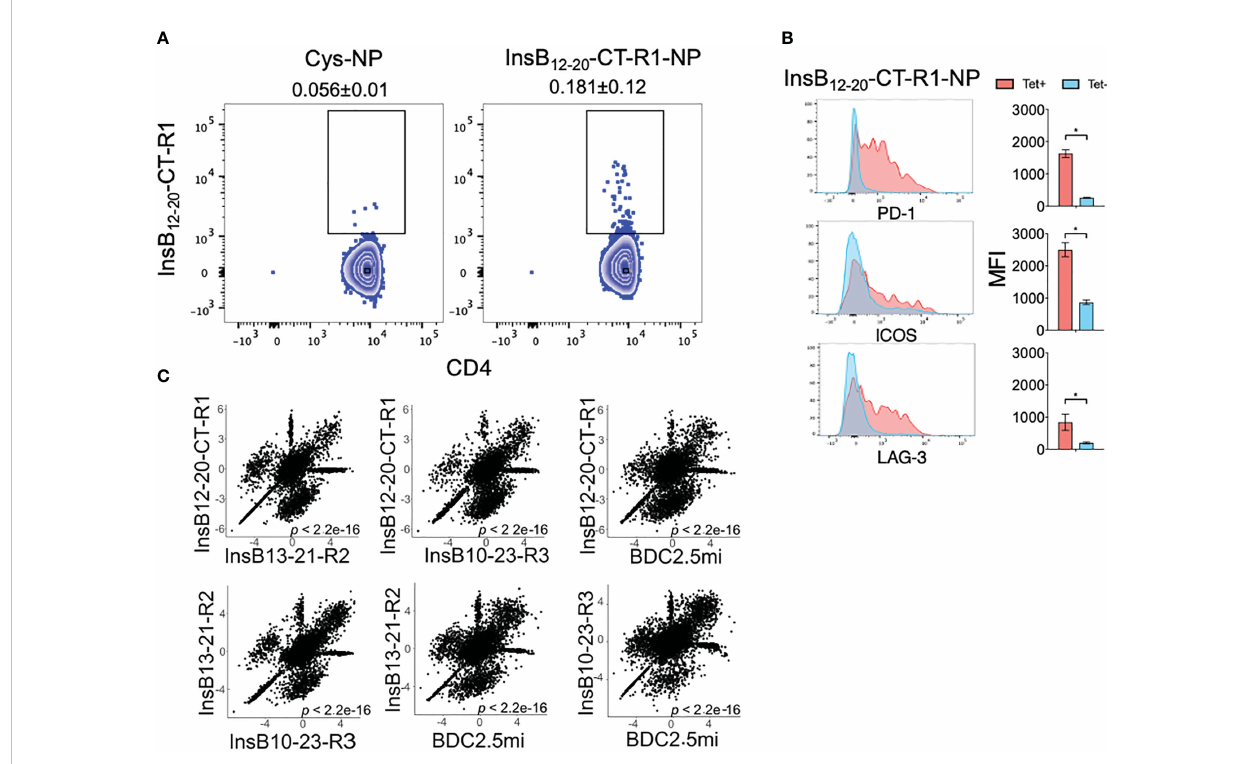
FIGURE 2 pMHCII-NP-induced TR1-like cell formation in pre-diabetic NOD mice in vivo . (A) Cognate tetramer staining pro fi les of splenic CD4+ T cells from NOD mice treated with NPs coated with pMHCIIs displaying the InsB 12-20 -CT-R1 epitope. Left panel, Cys-NP (control)-treated mice; Right panel, pMHCII-NP-treated mice. The average ± SEM values shown on top of each plot correspond to the percentages of Tet+ cells within the CD4+B220 – gate (n=6 and 3 mice/NP type, respectively). (B) Flow cytometry staining pro fi les and average ± SEM mean fl uorescence intensity (MFI) staining values for PD-1, ICOS and LAG-3 on tetramer+ versus tetramer – splenocytes. *, P<0.05 (Mann-Whitney U test). (C) Correlation between the levels of gene expression among tetramer+ cells isolated from mice treated with InsB 12-20 -CT-R1/IA g7 -NP, InsB 13-21 -R2/IA g7 -NP, InsB 10-23 -CT-R3/IA g7 -NP and BDC2.5mi/IA g7 -NP as compared to tetramer – cells (Tconv control) puri fi ed from InsB 12-20 -CT-R1/IA g7 -NP-treated mice. The P value refers to the Pearson correlation coef fi cient for each